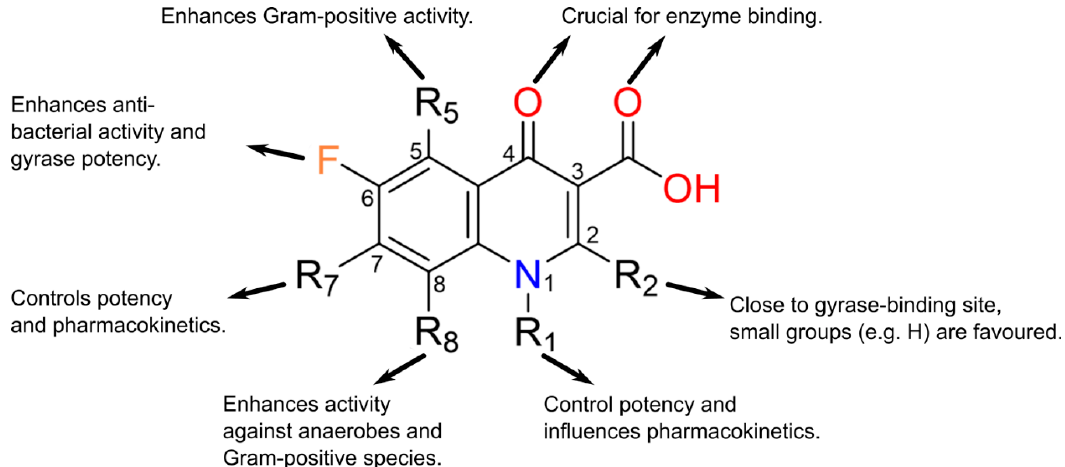
Figure 2. The observed structure-activity relationships (SARs) of quinolone core substitutions. Most often R5 = H, but sparfloxacin (a discontinued 3rd-generation fluoroquinolone (FQ)) has R5 = NH 2 (diagram adapted from [32] , with permission).